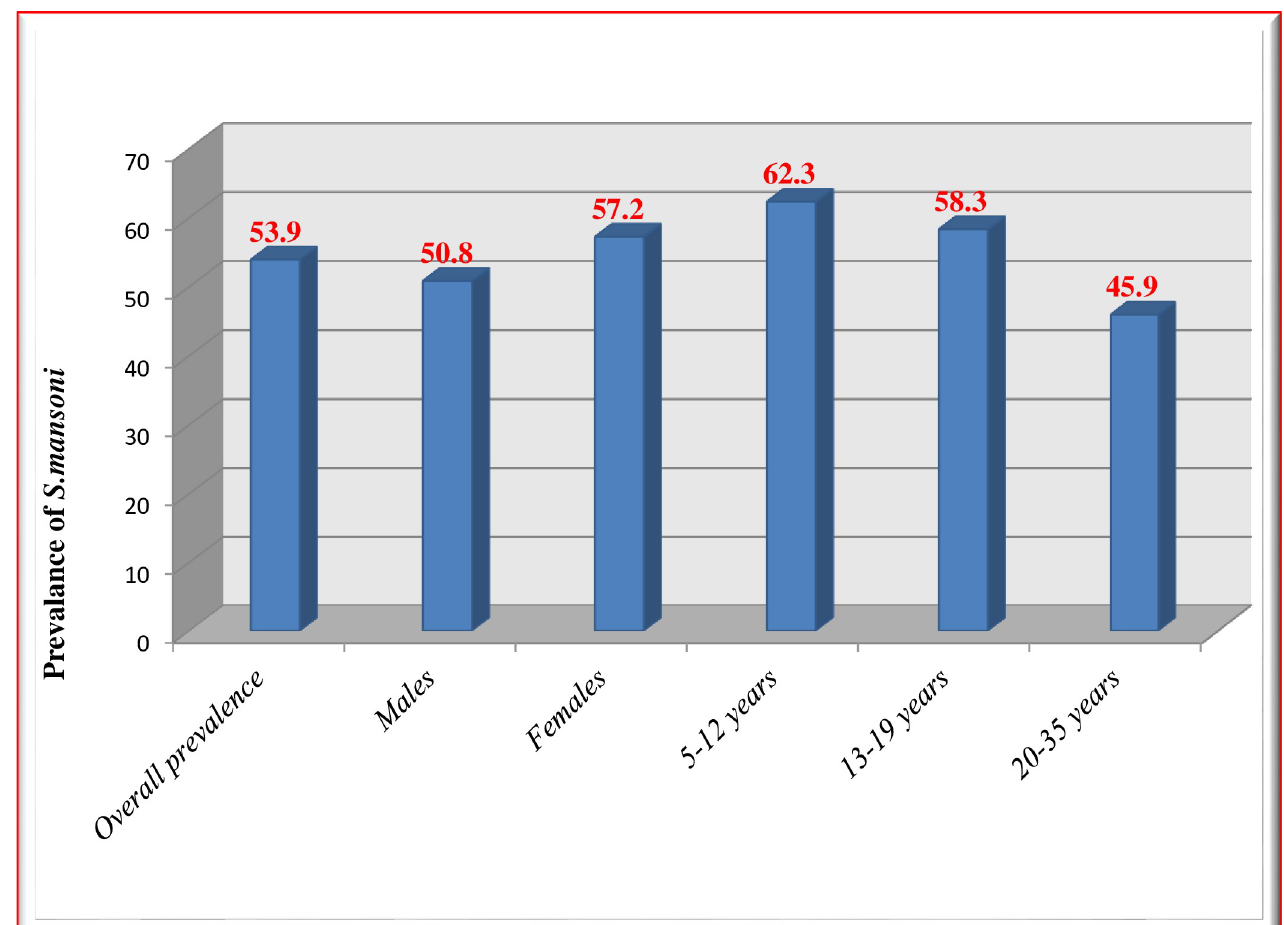
Fig 2. Prevalence of S. mansoni infections across sex and age